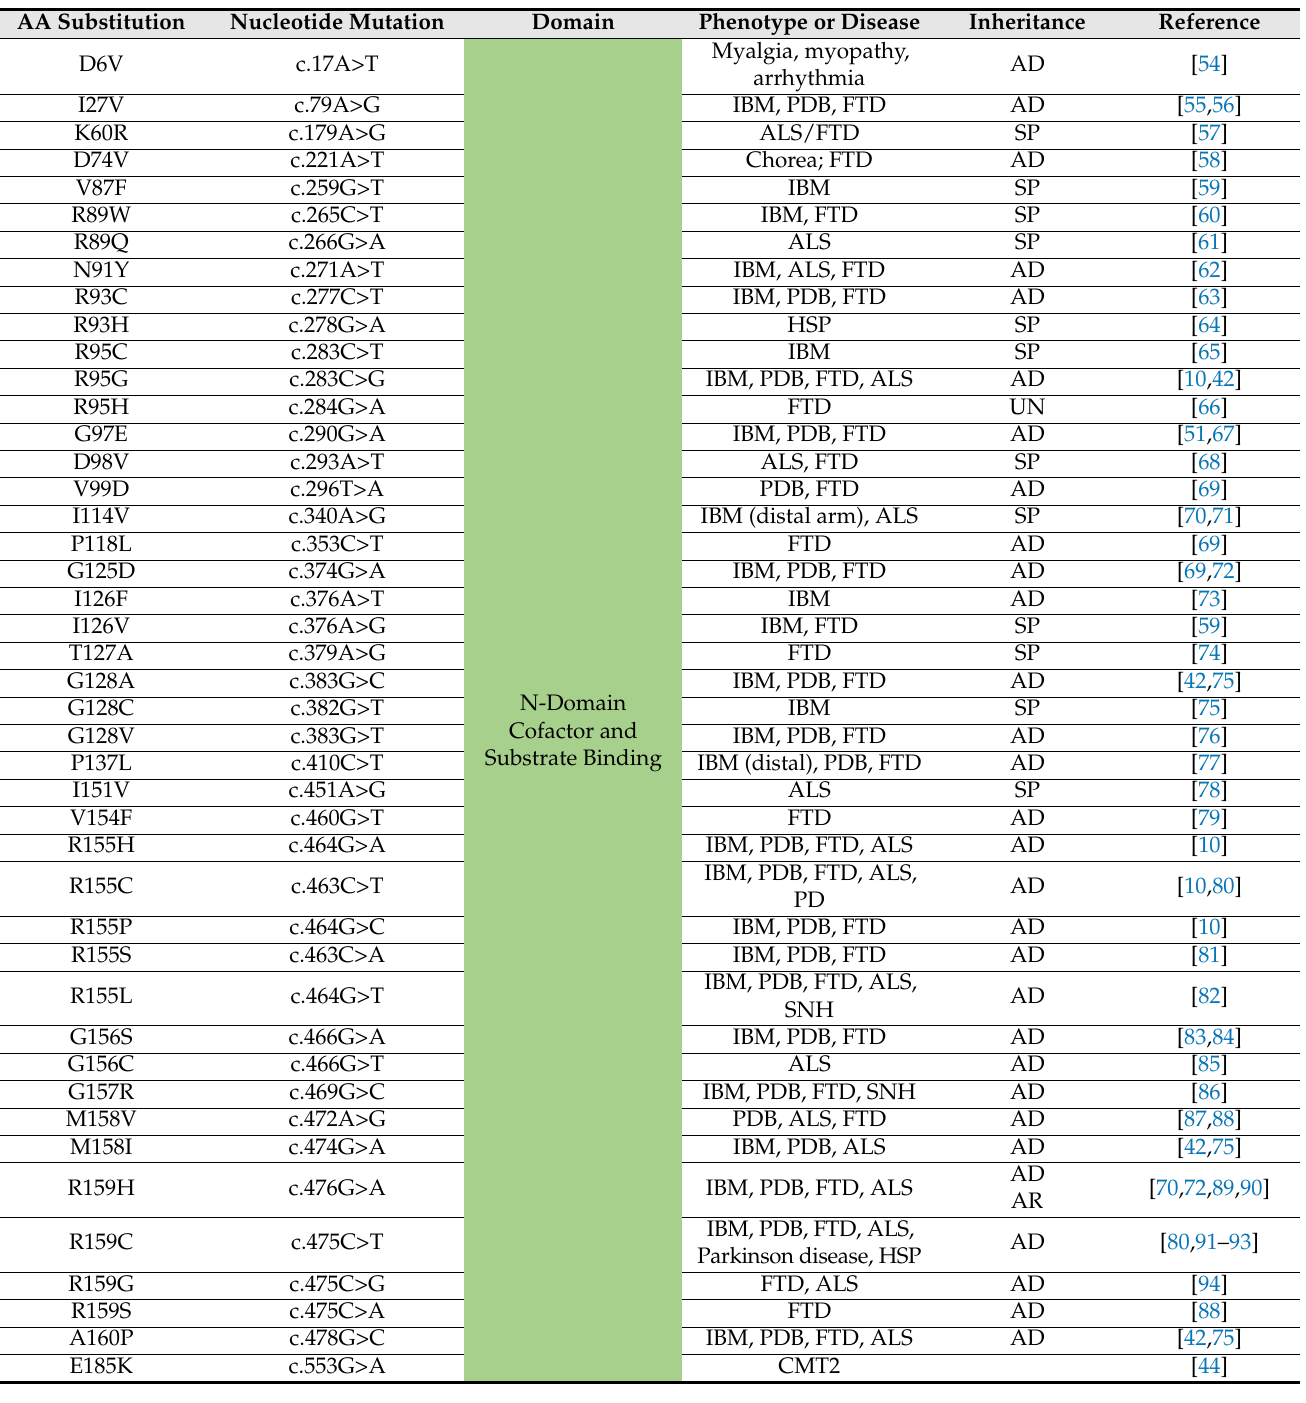
Table 2. Mutations in VCP organized by domain, and genotype-phenotype